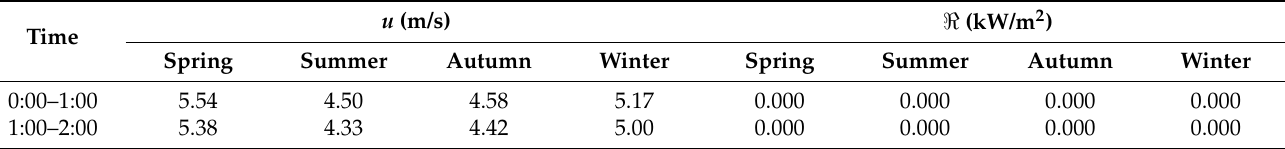
Table A3. Values of time-varying wind speed and radiation intensity in Case